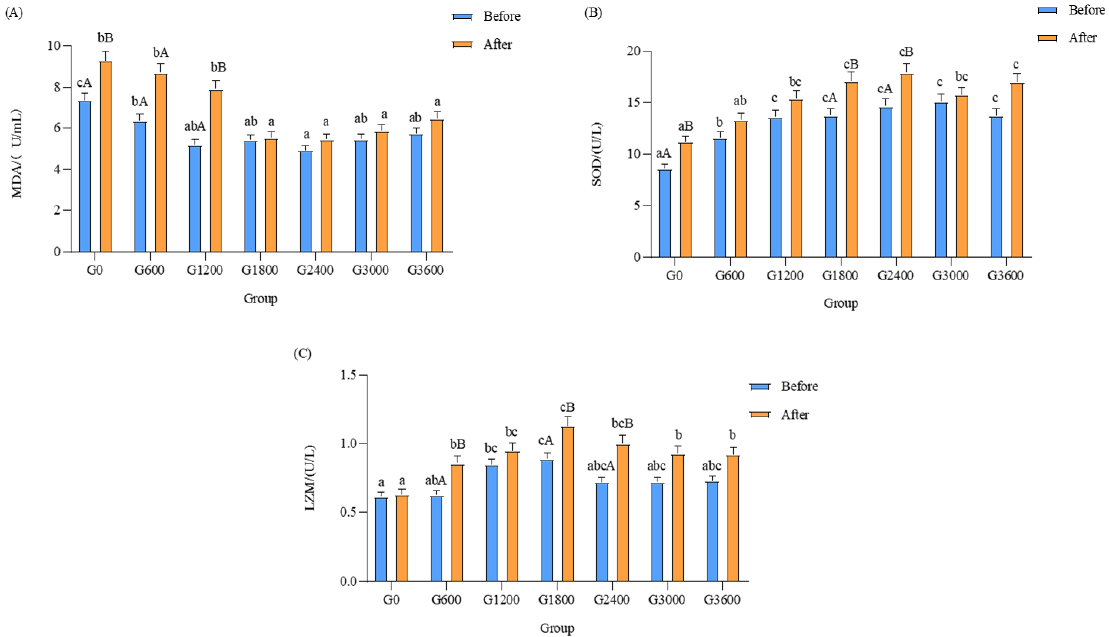
Figure 4. Effects of dietary GML levels on liver MDA ( A ), SOD ( B ) and LZM ( C ) activities in bacterial challenge test for juvenile grouper. Data represent means of three tanks in each group; error bar indicates S.D. Values with different letters are significantly different ( p < 0.05). LZM: lysozyme. SOD: superoxide dismutase. MDA: